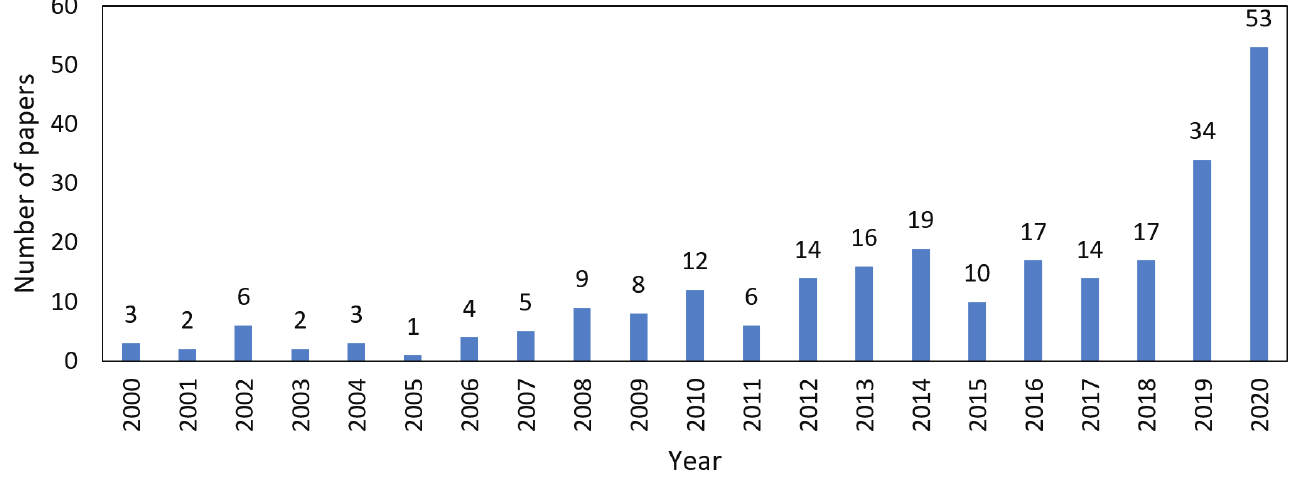
Figure 4. Publication history of paper on human landscape perceptions